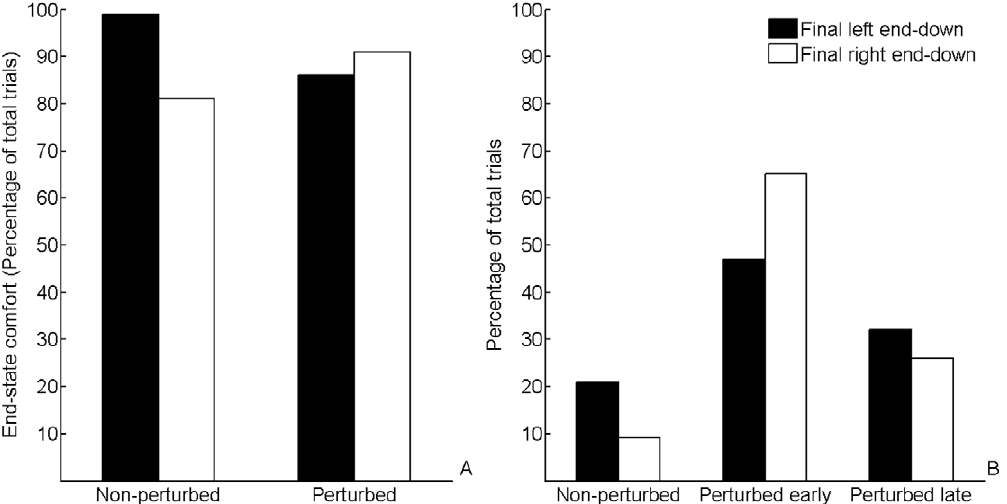
Figure 3. End-state comfort satisfaction and employment of correction strategy. (A) Proportions of trials in which initial grasp postures resulted in comfortable end postures (i.e., end-state comfort) for non-perturbed and perturbed trials. (B) Proportions of trials in which participants employed an early correction strategy, a late correction strategy, or did not change initial grasp posture (no-correction). Black bars refer to left end- down conditions. White bars refer to right end-down